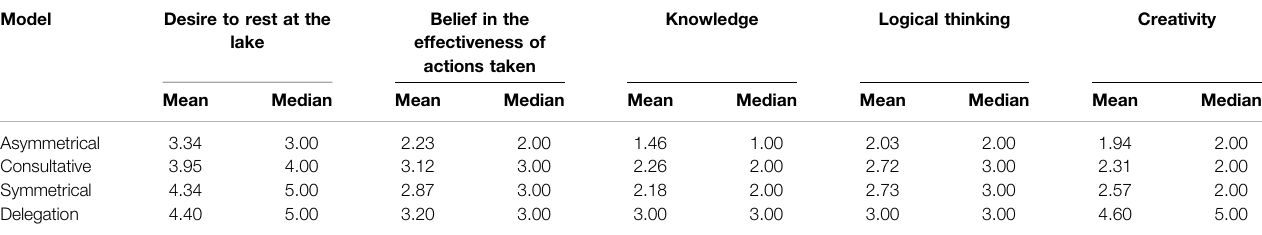
TABLE 4 | The means and medians for the features determining the individual participation models. Model Desire to rest at the